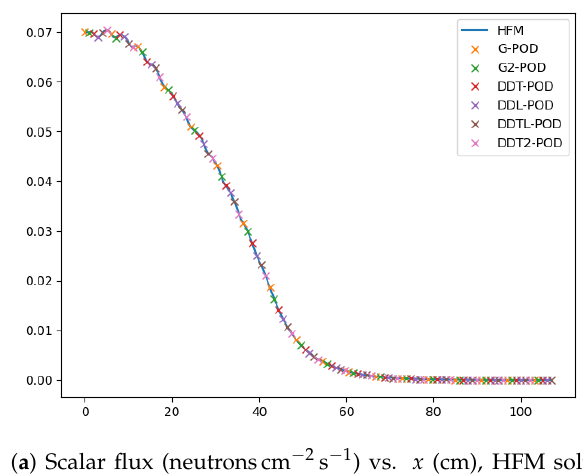
tion in blue, POD-based Reduced-Order Models (ROMs) in crosses. Figure 4. Scalar flux for Energy Group 1 for the HFM (blue) and POD methods and the pointwise error between them with parameters R 1 = 2, R 2 = 2, R 3 = 1, R 4 = 1, R 5 = 4.